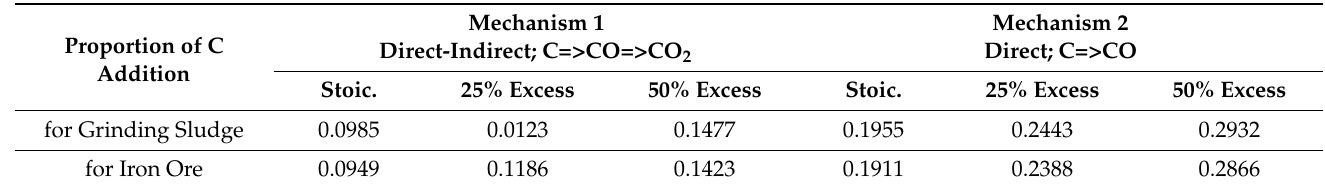
Table 6. Amount of carbon added to iron oxide for carbothermic reducing.